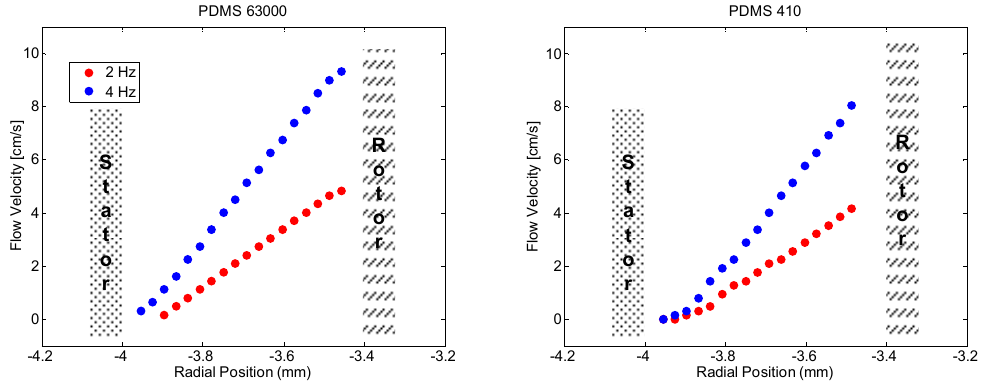
Figure 1. Velocity profiles across the gap in the Couette cell for two velocities for the two samples extracted from three-dimensional flow NMR data.